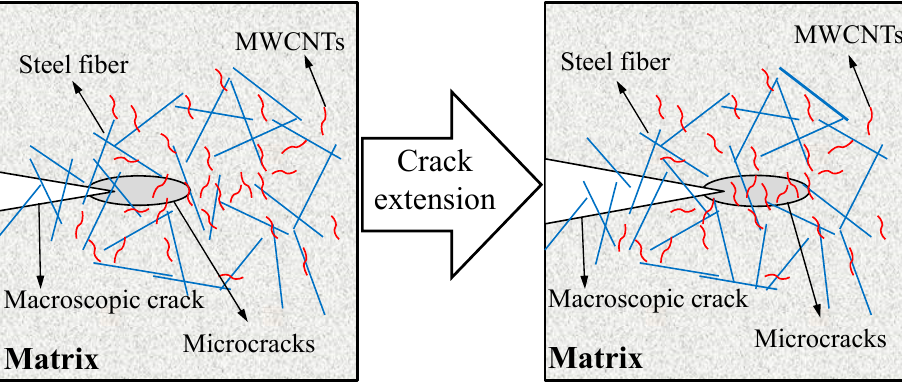
Figure 9. Schematic diagram of toughening mechanism of MWCNTs in RPC.